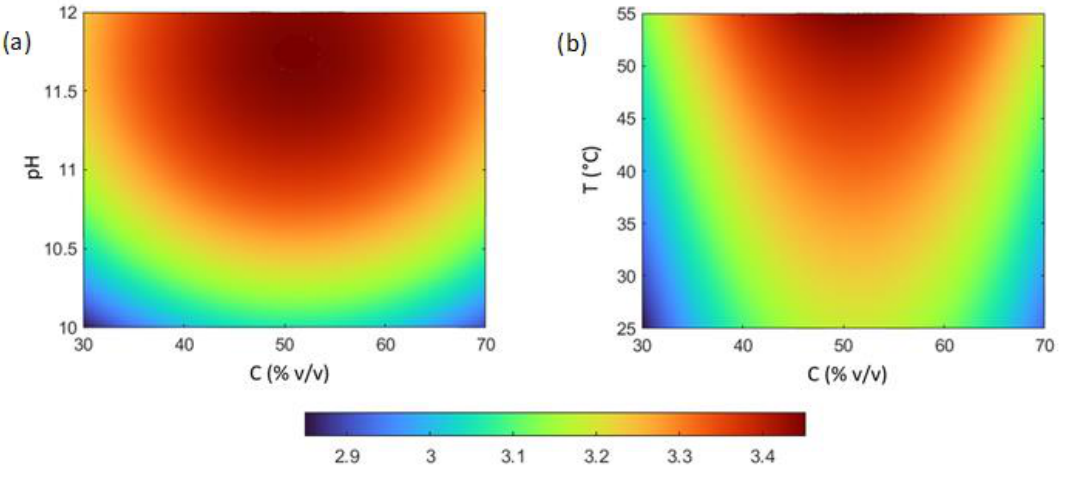
Figure 7. Representative contour plots showing the effects on the intensity of the SPR band ( I max ) of: ( a ) pH and solvent composition (C); ( b ) temperature (T) and solvent composition (C). For each plot, the levels of the other factors were fixed at their central values (C = 50% v / v ; R = 5 mol/mol; T = 40 °C; pH = 11).